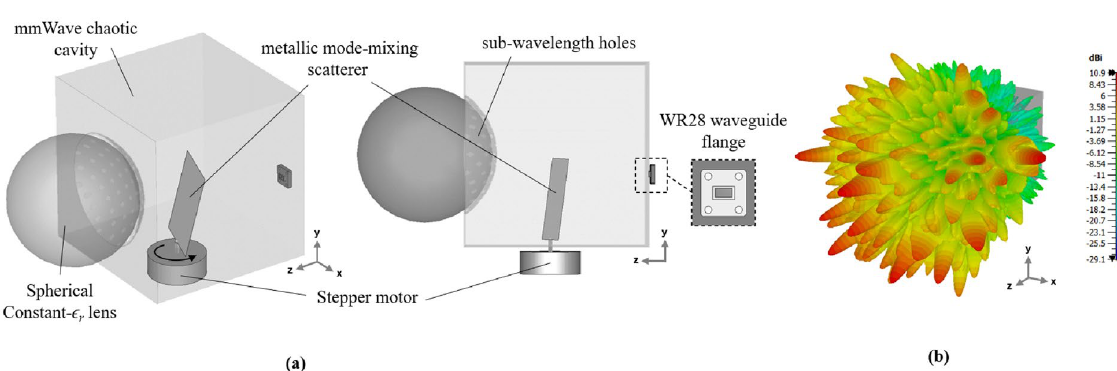
Figure 2. ( a ) Lens-loaded cavity structure with a mode mixing scatterer connected to a stepper motor to include state-diversity. ( b ) Simulated peak realized gain representing high and low magnitude values on the radiation mask when a test signal of 28.1 GHz is excited at the WR28